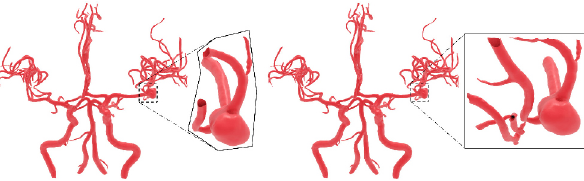
Fig. 3 In contrast to grid sampling, our sampling based on geodesic distance avoids involving noisy blood